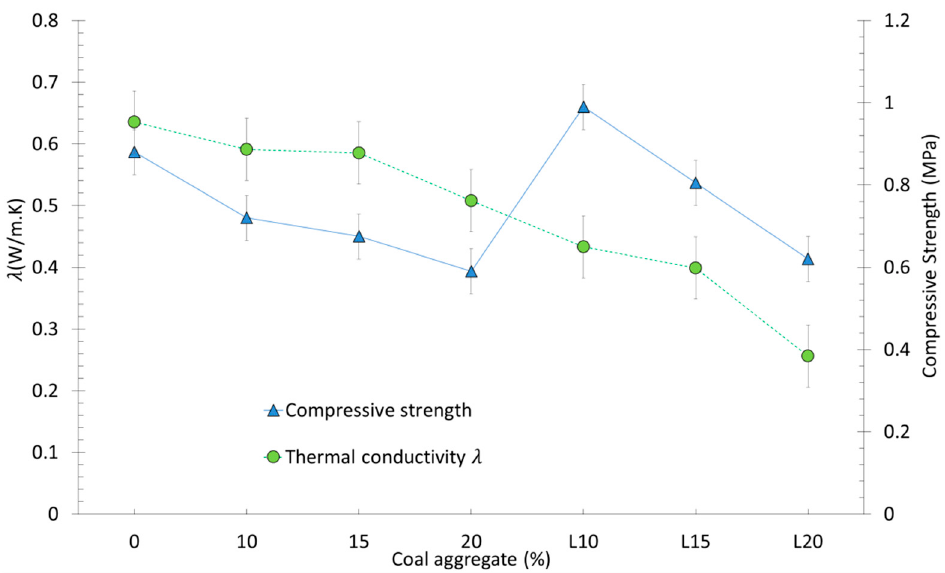
Figure 12. Thermomechanical diagram of the different CEB formulations.